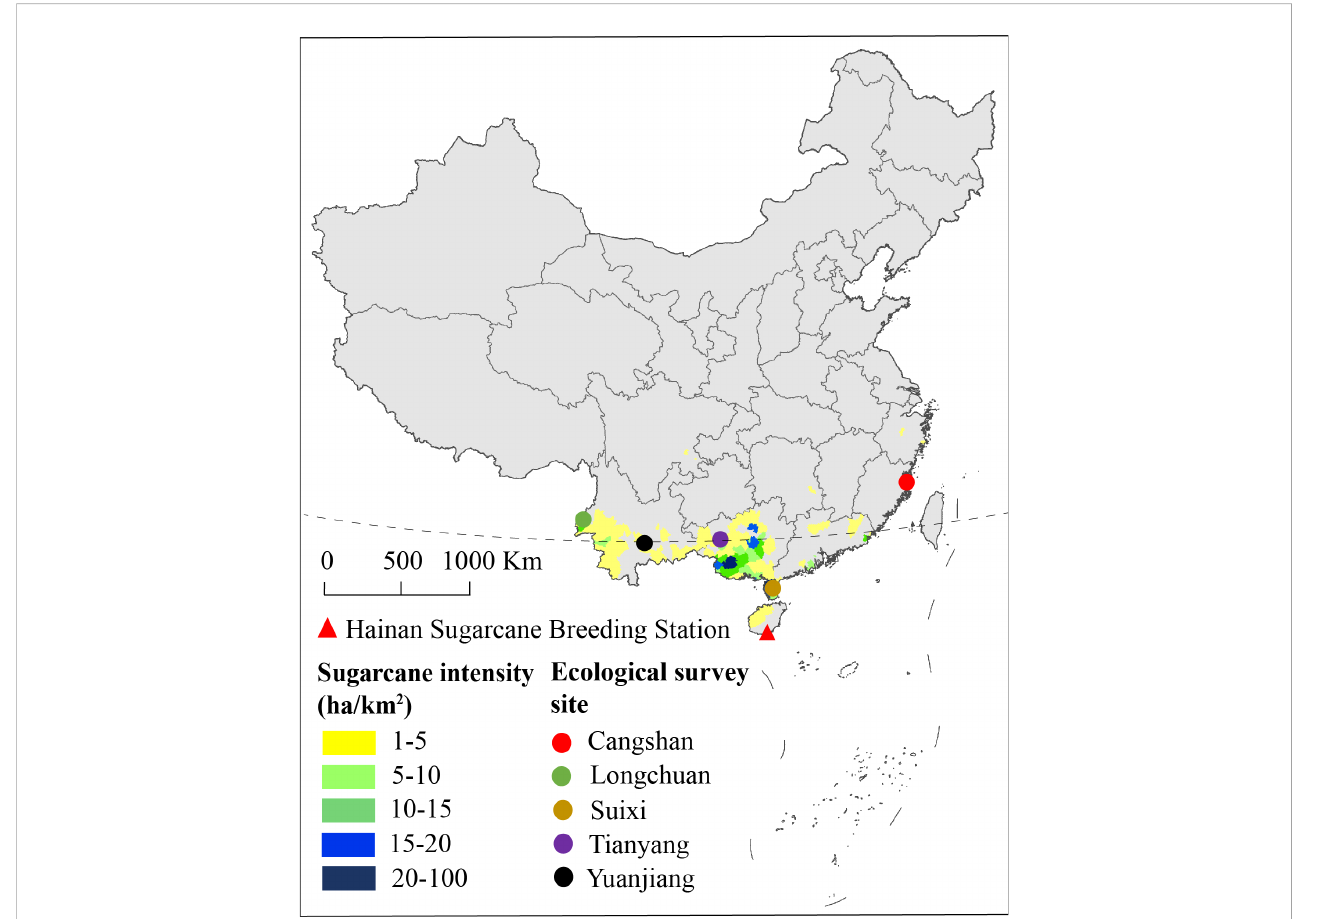
FIGURE 1 Ecological survey sites and sugarcane crop density in China based on the data from the 2020 Statistical